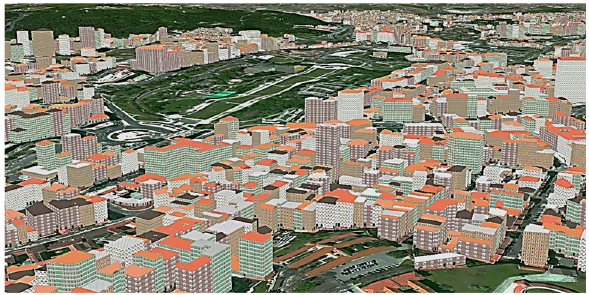
Fig. 4 3D model of Lisbon with actual situation appearance (generic facade textures)